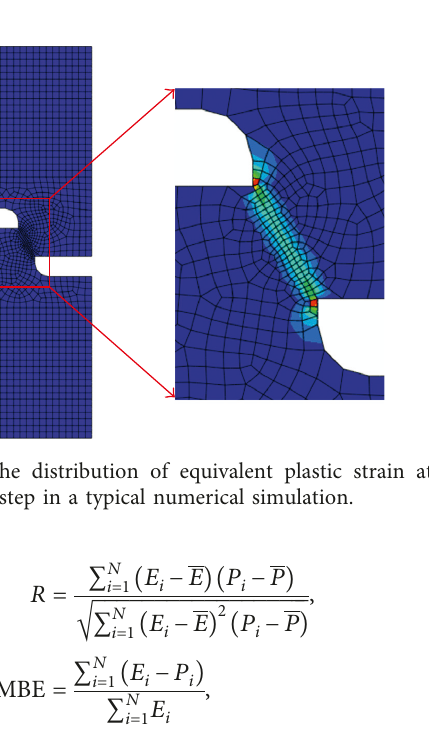
Figure 13: Comparison between numerical simulations and experiments.